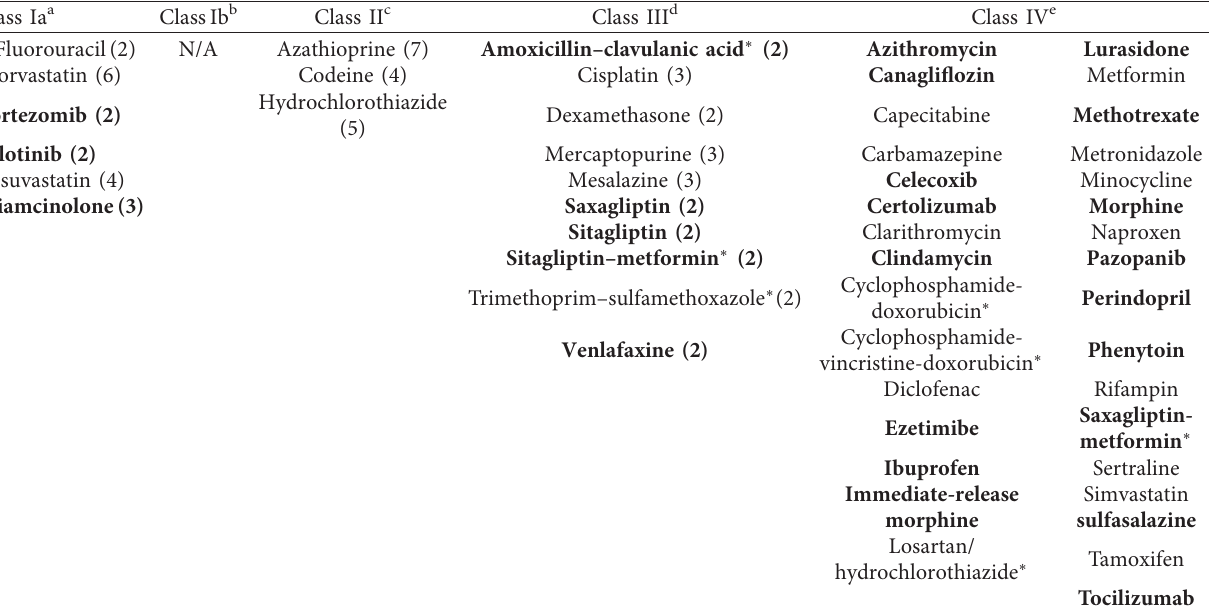
Table 3: Drug-induced acute pancreatitis causative drugs (number of hospitalizations) classified according to the evidence-level classi- fication system proposed by Badalov and colleagues [12] ( n �